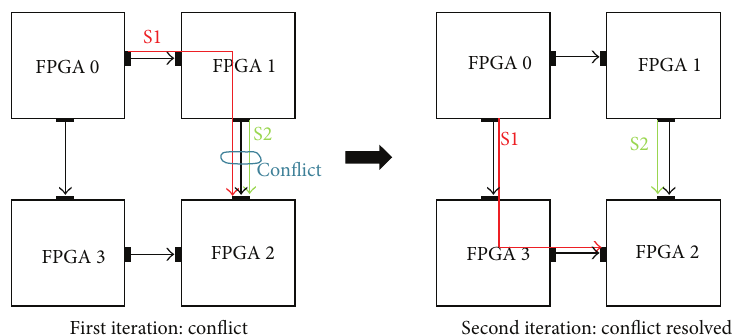
Figure 5: Conflict resolution by an iterative routing algorithm.